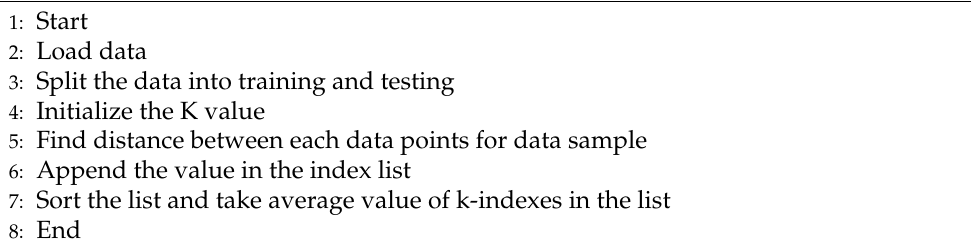
Algorithm 3 An algorithm for K-nearest neighbor for